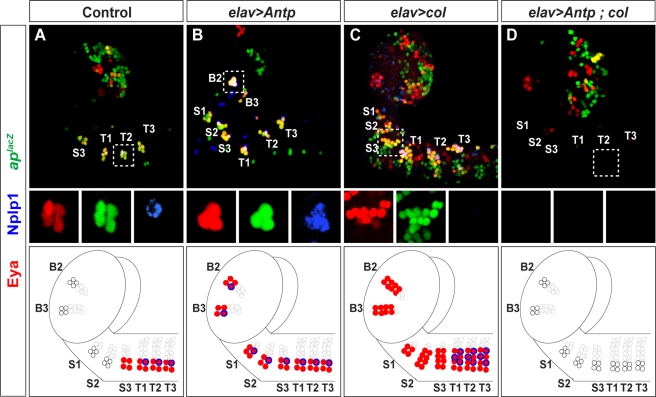
Misexpression of Antp triggers Ap cluster formation in anterior NB 5–6 lineages.(A and B) Compared to control (A), pan-neuronal misexpression of Antp (B) triggers ectopic formation of Ap-clusters into brain segment B2, as evident by the coexpression of Eya, aplacZ, and Nplp1. Small boxes show the expression of Eya, Nplp1, and aplacZ expression in separate panels. (C) Misexpression of col triggers ectopic Eya and aplacZ expression throughout the anterior CNS. However, despite extensive Eya/aplacZ coexpression, we find no evidence of Nplp1 expression, confirming the notion that Antp plays additional roles beyond activating col. (D) Misexpressing Antp in a col mutant background, reveals a complete loss of Ap clusters in thoracic segments (the col mutant phenotype), and a failure to trigger ectopic anterior Ap cluster, evident by the absence of Eya/aplacZ/Nplp1 expressing clusters, demonstrating that Antp requires col to trigger Ap cluster formation. Genotypes: (A) aplacZ;elav-Gal4/+. (B) aplacZ/UAS-Antp;elav-Gal4/+. (C) aplacZ/UAS-col;elav-Gal4/+. (D) col3, aplacZ/col1; elav-Gal4/UAS-Antp.